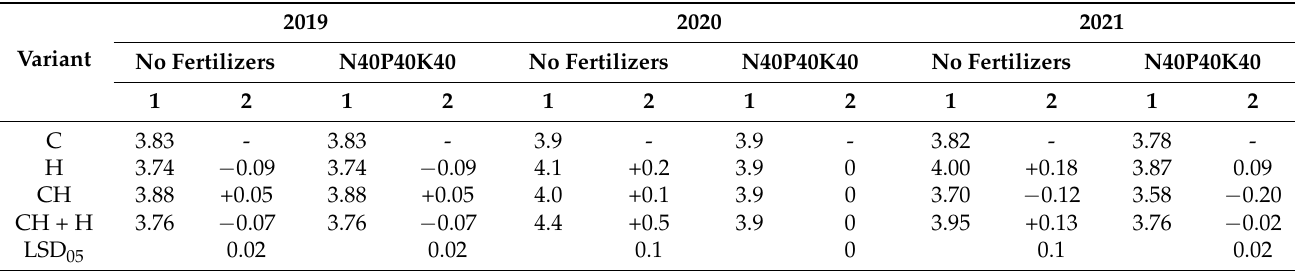
Table 11. The content of humus in the arable layer of carbonate chernozem according to the variants of the experiment with mineral fertilizer and humic preparation under